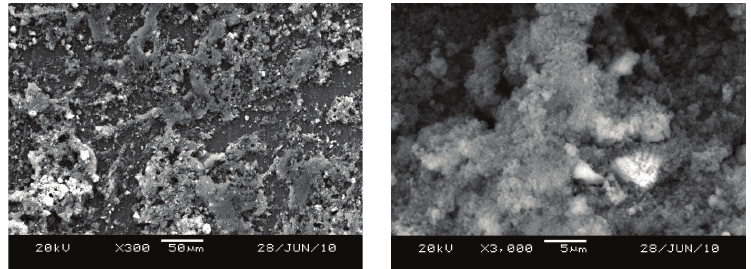
Figure 4: Low and high resolution SEM images of structure on surface (CA = 150 ∘ ).